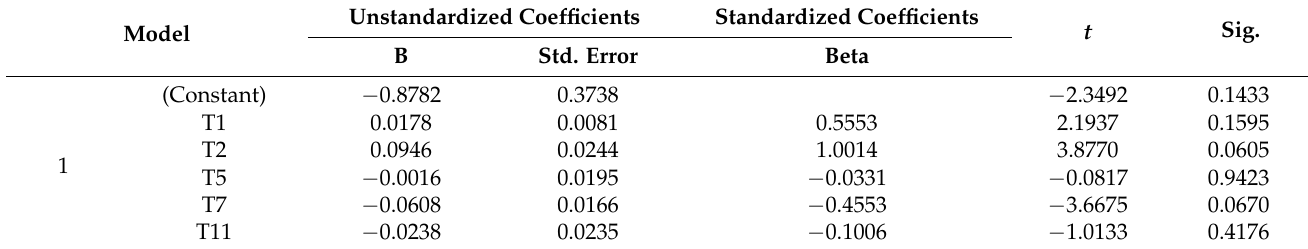
Table 10. Coefficients of